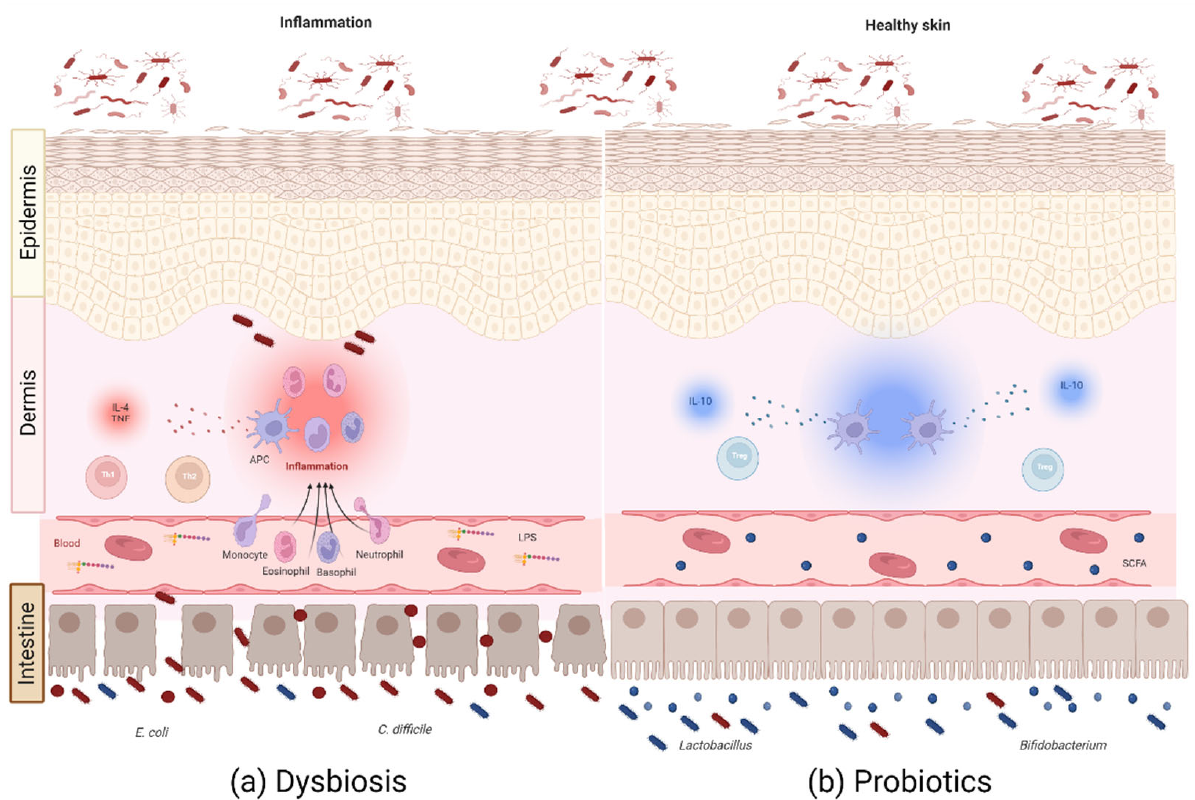
Figure 2. Microbiota–gut–skin axis. Bidirectional communication between the gut microbiota and skin occurs through bacterial metabolites, bacterial translocation, and immune system modulation, either by pathogens or probiotics. ( a ) Intestinal dysbiosis plays an important role in the inflammatory state of the skin in several dermatoses through the increase in proinflammatory metabolites, cytokines, and lymphocytes. ( b ) Probiotics help restore the balance through the increase in anti-inflammatory metabolites, such as SCFAs, immune cells, such as Treg lymphocytes, and cytokines, such as IL-10, to reduce and control the inflammation produced during these cutaneous pathologies: SCFAs, short-chain fatty acids; APC, antigen-presenting cell. Created with